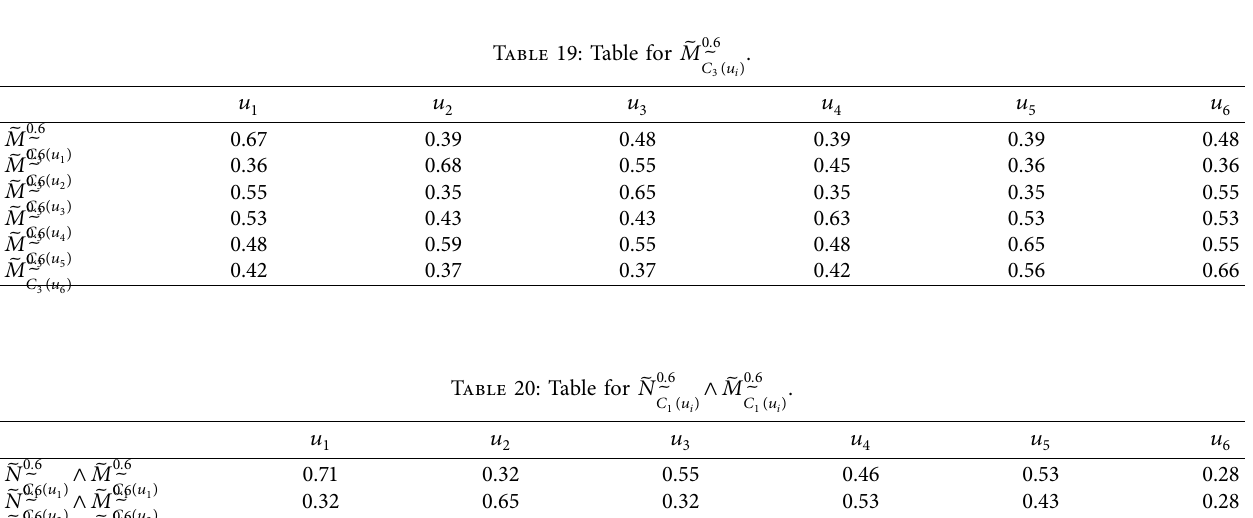
Table 19: Table for 􏽥 M 0 . 6 􏽥